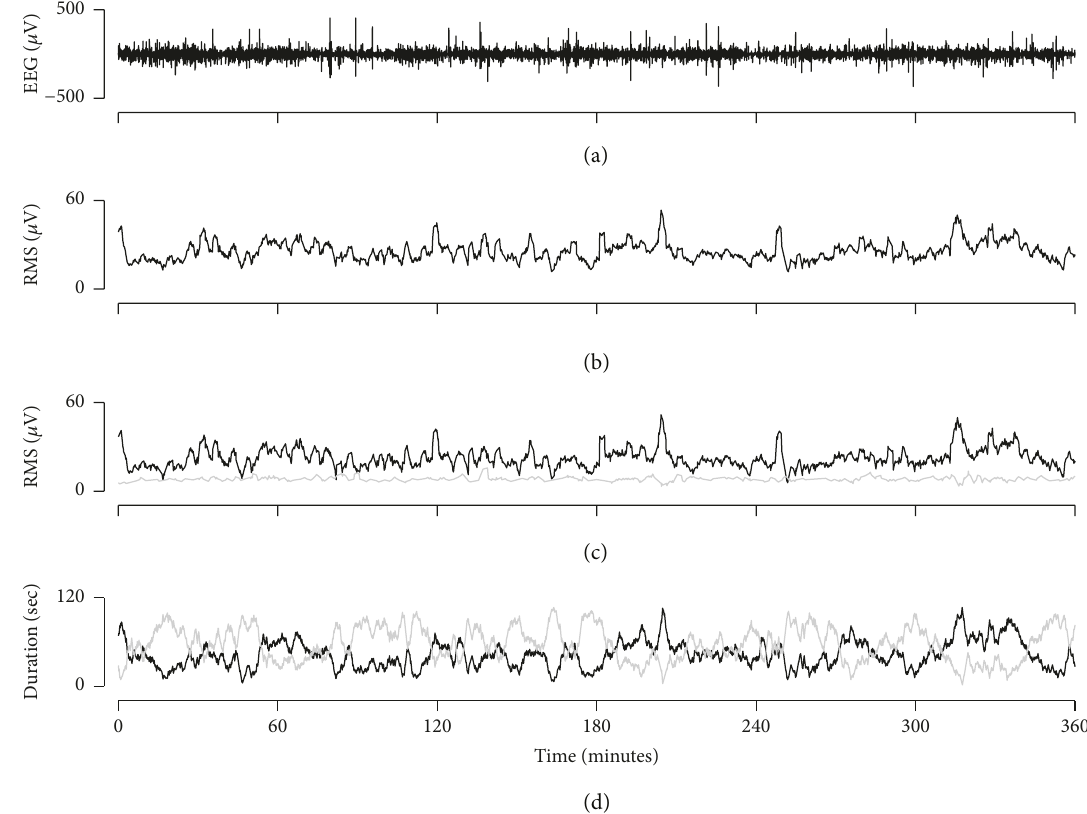
Figure 2: Illustration of the features computed from the EEG signal. (a) illustrates a 6-hour long EEG segment for one neonate in the group of study (PMA 27 weeks, 0.5mg · kg − 1 ). (b) illustrates the running RMS value. (c) and (d) illustrate the running RMS and running duration values for BIs (black) and IBIs (gray), respectively.